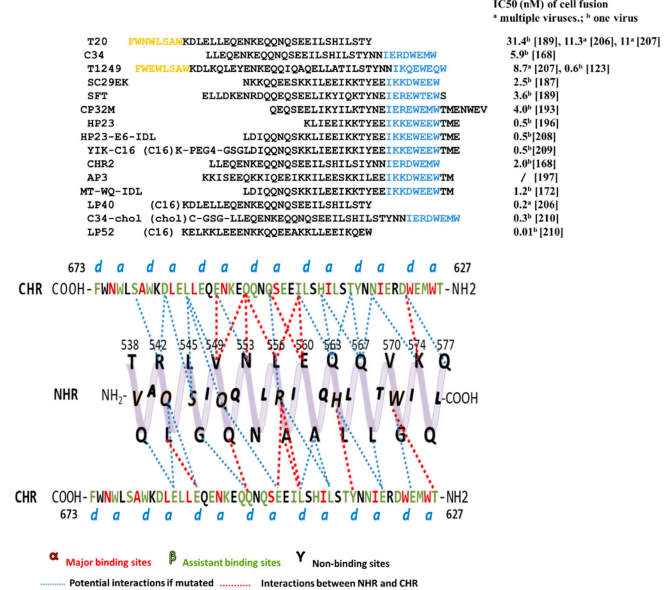
Figure 3. Tripartite model of gp41 N-terminal heptad repeats (NHR) with side view and C-terminal heptad repeats (CHR)-derived peptides. Above, the sequences of CHR-peptides targeting NHR. Residues represent pocket-binding domain and lipid- binding domain marked in blue and orange, respectively. Below, residues of CHR are divided into three groups: major binding sites α , assistant binding sites β , and non-binding sites γ . The potential interaction, or interaction, between CHR and NHR is shown in blue or red dashed